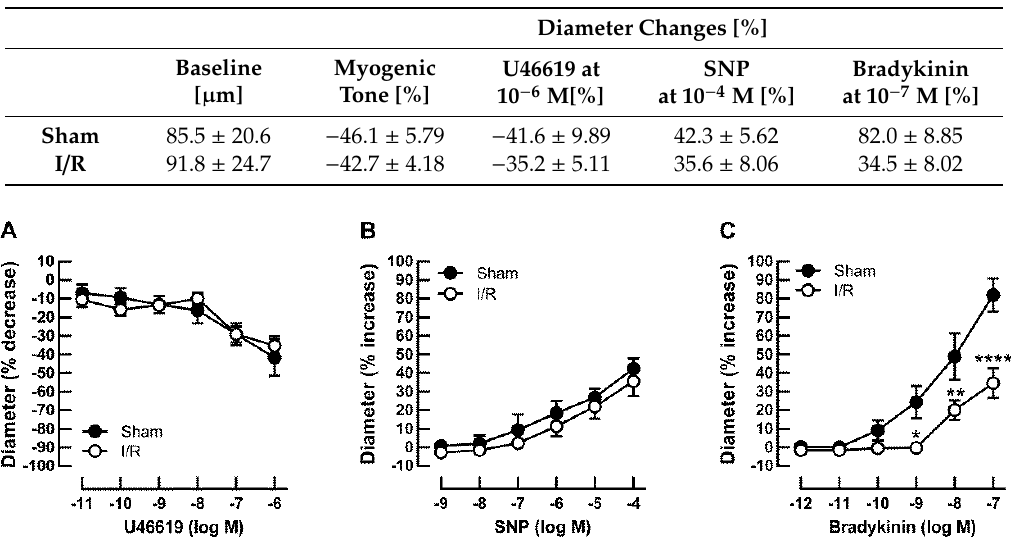
Figure 1. Time courses of cerebral oxygen saturation measured by INVOS ™ 5100C ( A ), of heart rate ( B ) and of mean arterial blood pressure (MAP) ( C ) at baseline (BL), during the occlusion time of 12 min (occlusion), 30 min after releasing the occlusion, and after a reperfusion time of 10 and 20 h. Data are expressed as mean ± SE ( n = 6 per timepoint and group, * p < 0.05, *** p < 0.001, **** p < 0.0001). I/R = ischemia-reperfusion. Table 1. Initial diameter (baseline) 5 min after cannulation; basal arteriolar tone after 45 min of equilibration (myogenic tone) in % from baseline. Maximum vascular diameter changes of retinal arterioles to the thromboxane mimetic, U46619, to sodium nitroprusside (SNP) and to bradykinin in % from baseline (myogenic tone). Data are presented as means ± SE.